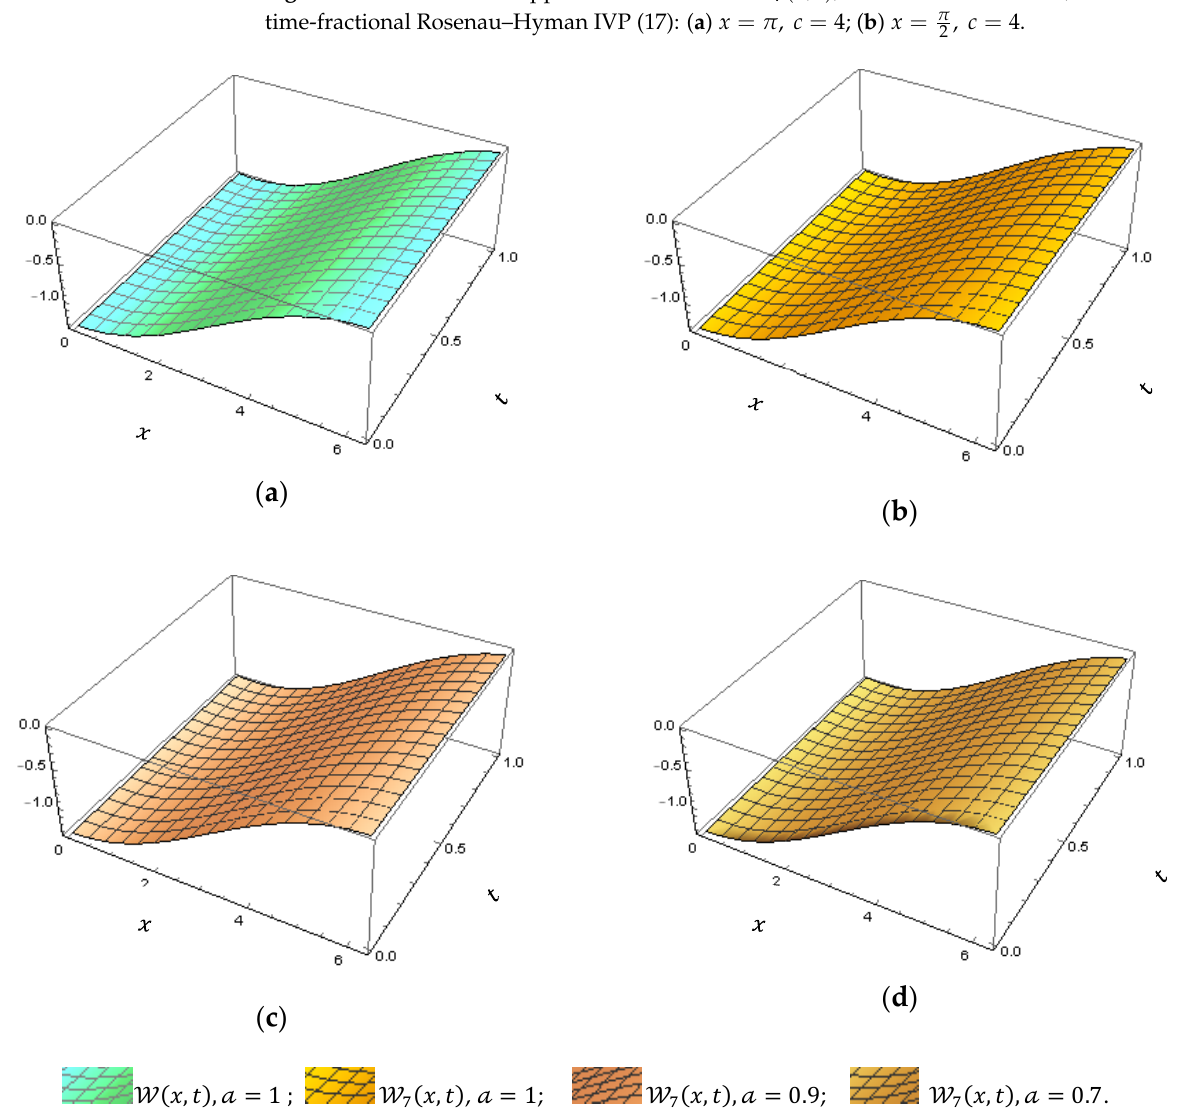
Figure 4. 3D Surface Plots of Exact solution W ( x , t ) , and the 7-th approximate solution W 7 ( x , t ) , for IVP (17), with 𝑡 ∈ [0,1] , and 𝑥 ∈ [0,2𝜋] , at various values of 𝒶 .